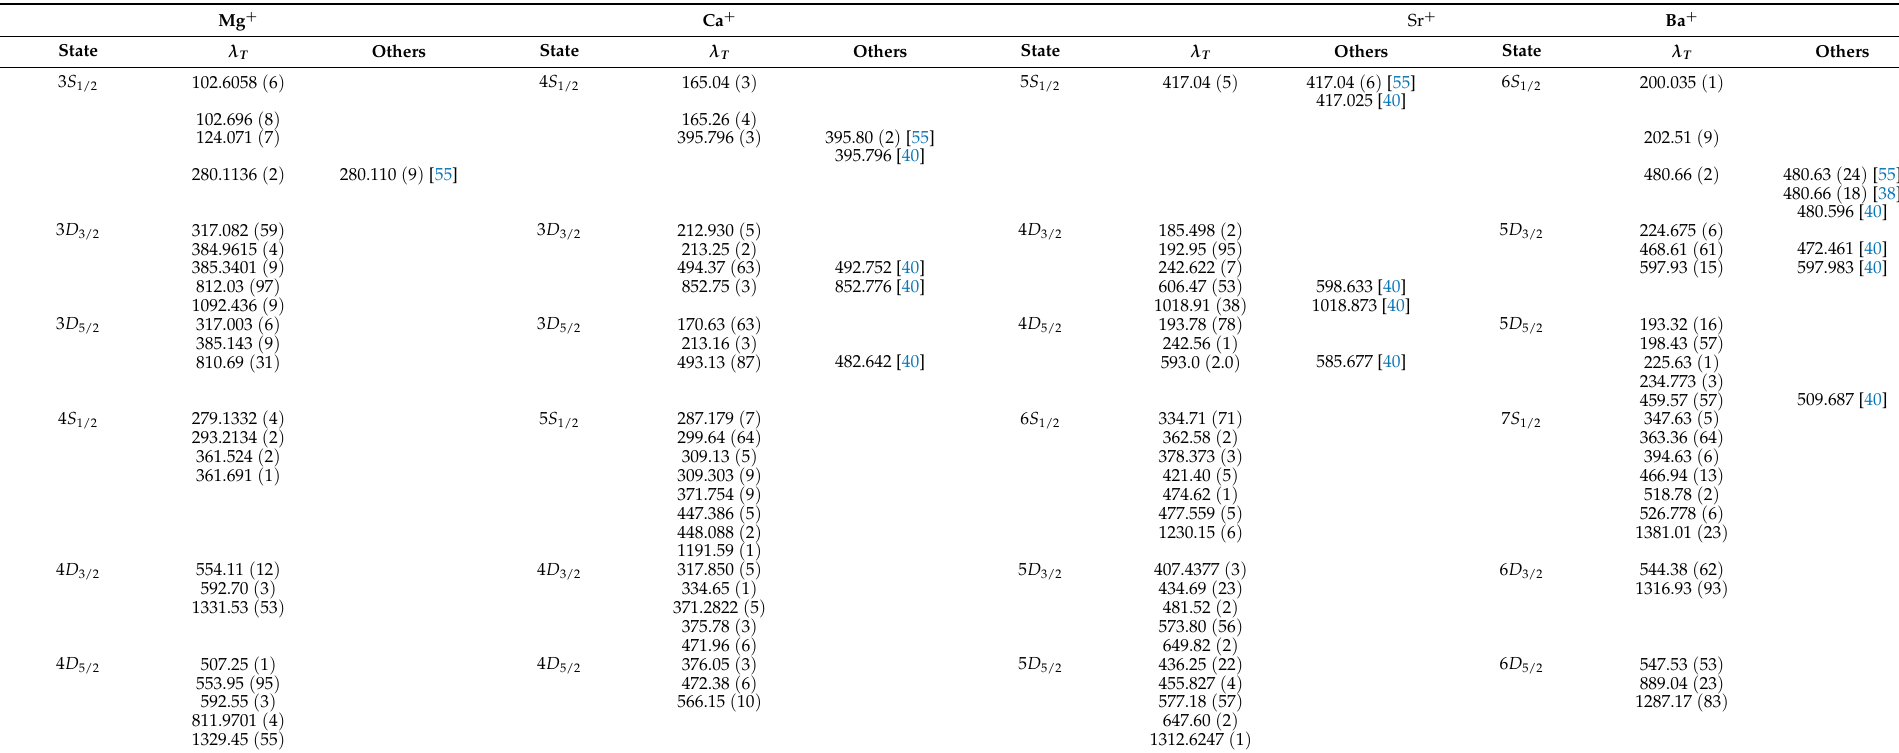
Table 5. Tune-out wavelengths λ T (in nm) of various states of Mg + , Ca + , Sr + and Ba + ions and their comparison with available